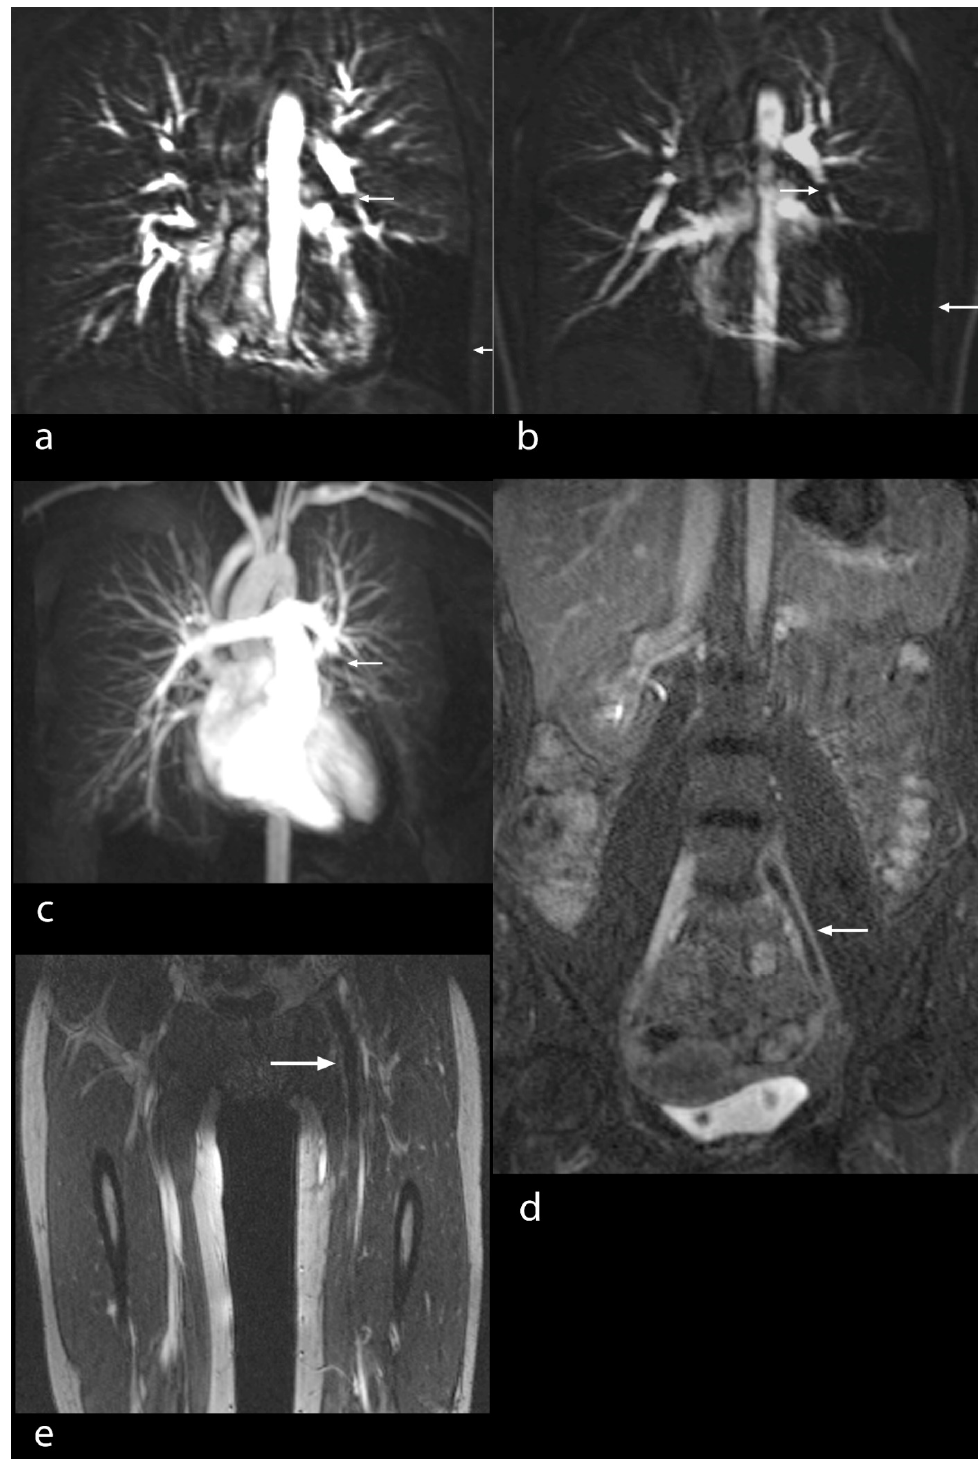
Figure 1. ( a , b ) Pulmonary MRA/MRV in a 20-year-old female patient under oral contraception and previously unrecognized factor V mutation. Thrombus in the left descending pulmonary artery (left arrow) with low enhancement in the capillary phase of the inferior pulmonary lobe (right arrow). Excellent examination quality; ( c ) 3D-MIP. Thrombus not visible. Total cut-off of the left pulmonary artery (see arrow). Perfusion deficit of the left inferior pulmonary lobe; ( d , e ) MRV, coronal. Thrombosis of the left iliac and the common femoral veins (see arrow). Good examination